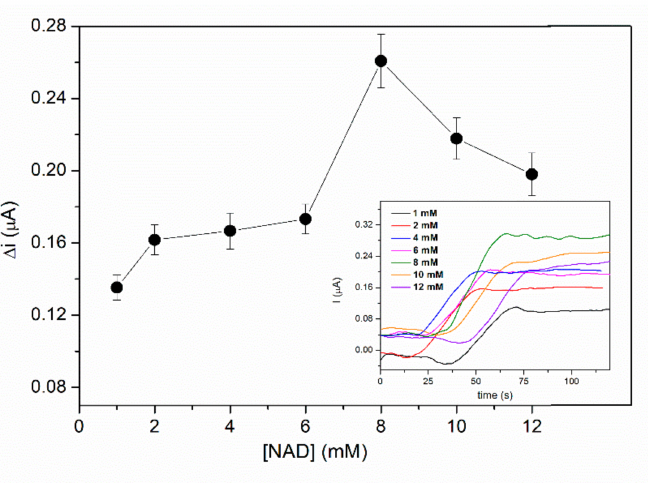
Figure 5. Influence of NAD + concentration on the biosensor response (E = +500 mV, PBS 0.1 M pH = 7.5, 2 mM L-lactic acid, n = 3) (inset: chronoamperometric response curves recorded for NAD + concentrations range 1–12